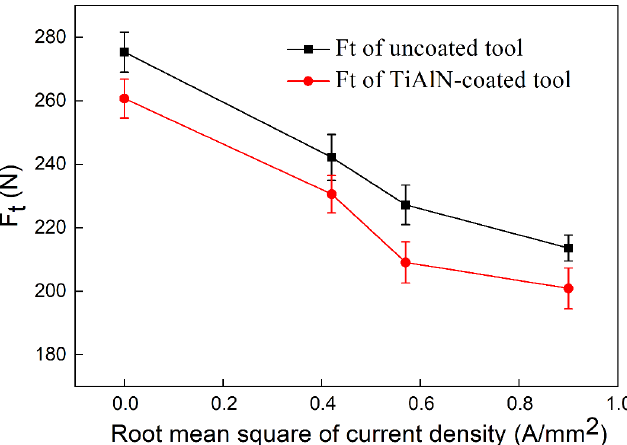
Figure 4. Schematic diagram of the variation curve of F t with the current strength.